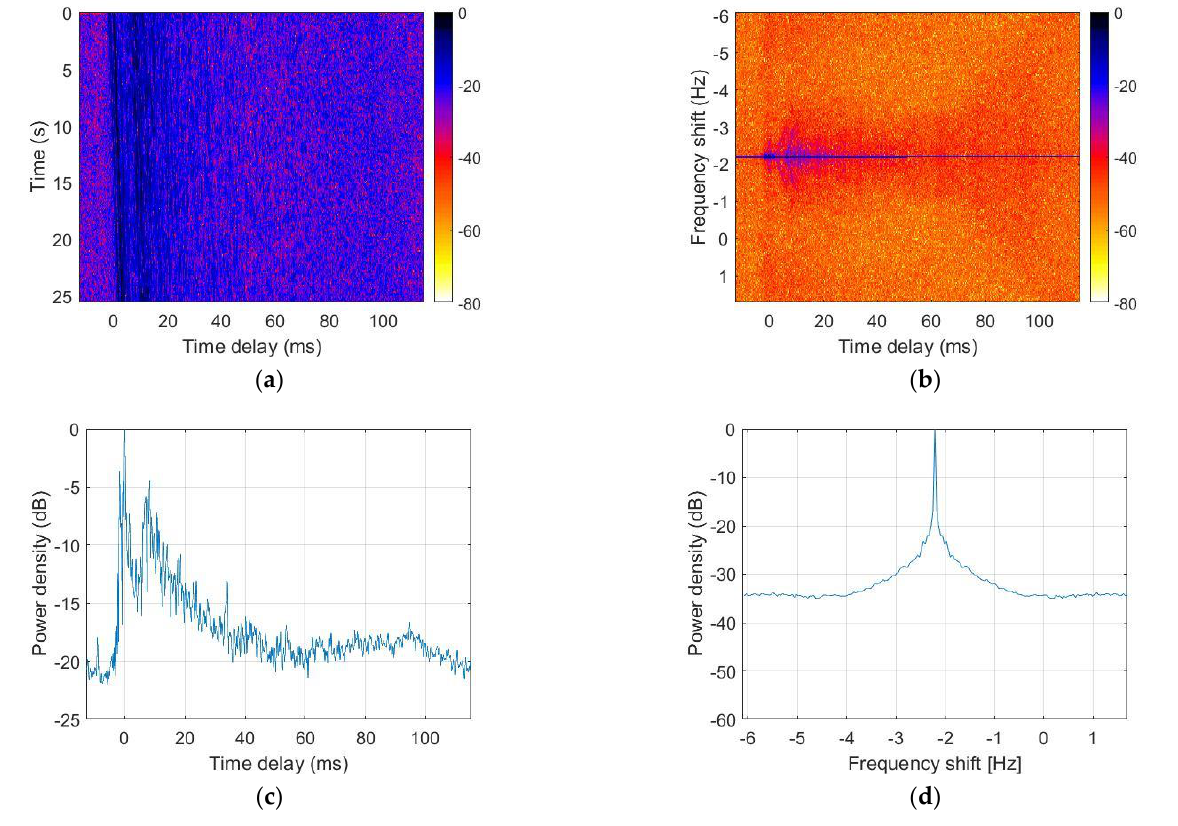
Figure 8. Underwater channel characteristics in the lake trial: ( a ) channel impulse response, ( b ) scattering function, ( c ) power delay profile, and ( d ) Doppler power spectrum.